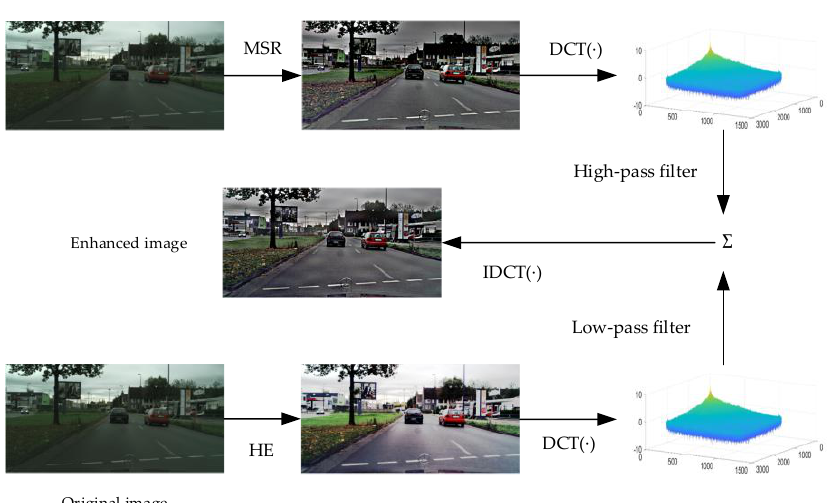
Figure 1. Overview of frequency − domain fusion based on MSR and HE.